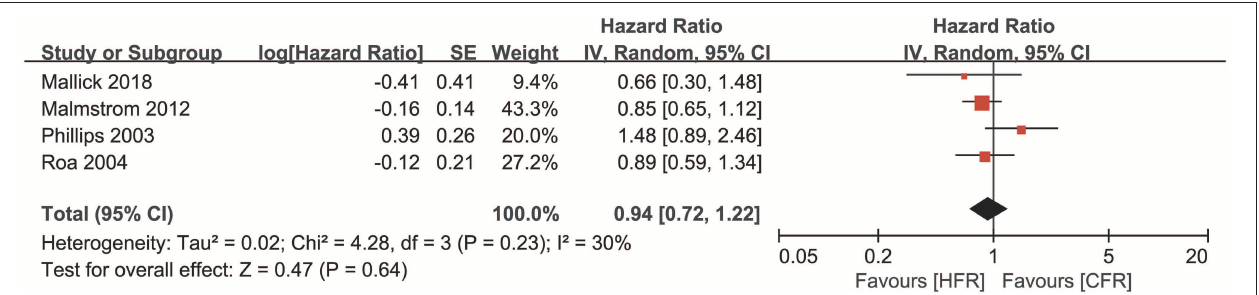
FIGURE 3 | Forest plots for overall survival between hoperfractionated radiotherapy (HFR) and conventional fraction radiotherapy (CFR).